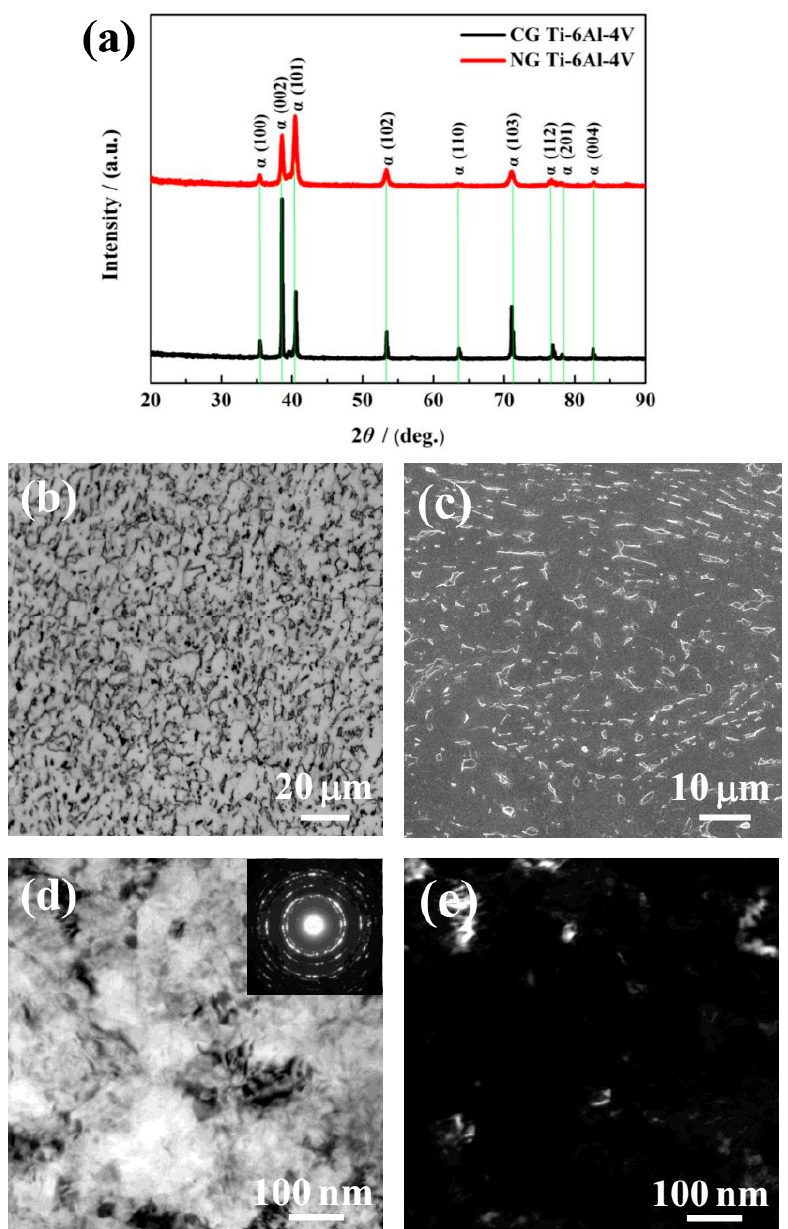
Figure 1. X-ray diffraction (XRD) patterns of nanograined (NG) and coarse-grained (CG) Ti–6Al–4V alloys ( a ). Optical micrograph ( b ) and SEM magnified images ( c ) for CG microstructure, TEM bright- field ( d ), and dark-field ( e ) micrograph for NG microstructure.